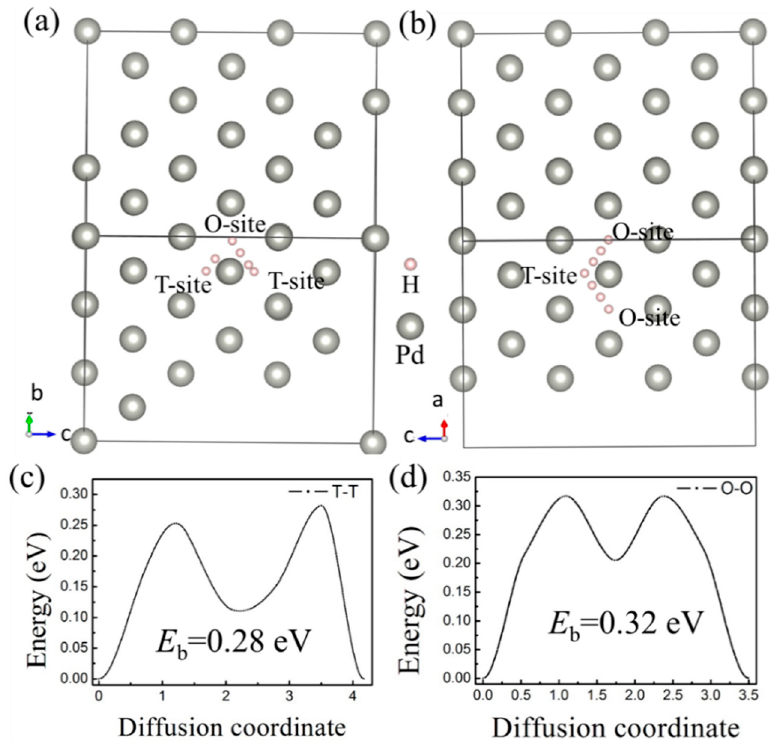
Figure 4. Diffusion pathways from ( a ) T-site to T-site (T-T) and ( b ) O-site to O-site (O-O) in bulk Pd. The corresponding diffusion barrier energy of ( c ) T-T and ( d ) O-O.